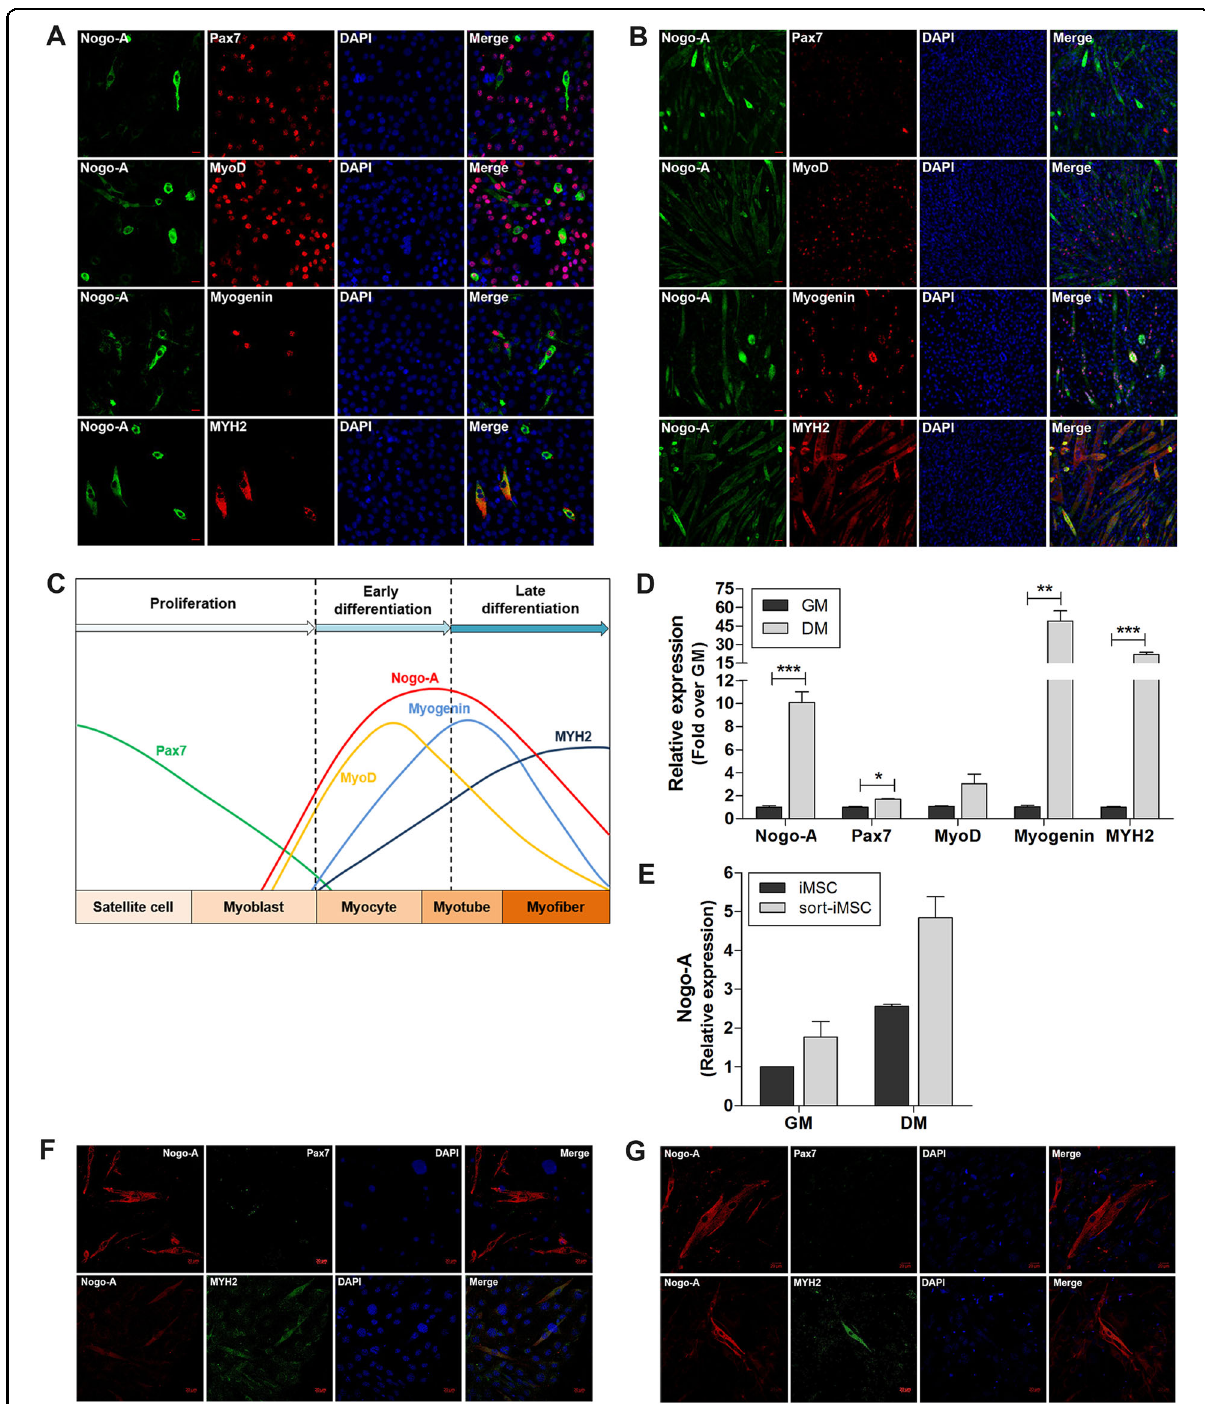
Fig. 4 Enhanced expression of Nogo-A and myogenic factors during myoblast differentiation. Cells were cultured in growth medium (GM) to maintain a proliferation/early differentiation state; differentiation was induced by incubating cells with differentiation medium (DM) for 3 days. A , B IF staining of Nogo-A (green) with Pax7, MyoD, myogenin, or MYH2 (red) in C2C12 mouse myoblast cells in early differentiation ( A ) and late differentiation ( B ). Scale bar = 20 µm. C Summary of the expression levels of Nogo-A and myogenic factors during myoblast differentiation. D qRT- PCR analysis of Nogo-A and myogenic factors in myoblasts ( n = 3/group). Mean ± SEM. * p < 0.05, ** p < 0.01, *** p < 0.001. E qRT-PCR analysis of Nogo- A in induced muscle stem cells (iMSCs) and sorted-iMSCs (sort-iMSCs). F , G IF staining of Nogo-A (red) with Pax7 or MYH2 (green) in differentiated iMSCs ( F ) and sort-iMSCs ( G ). Scale bar = 20